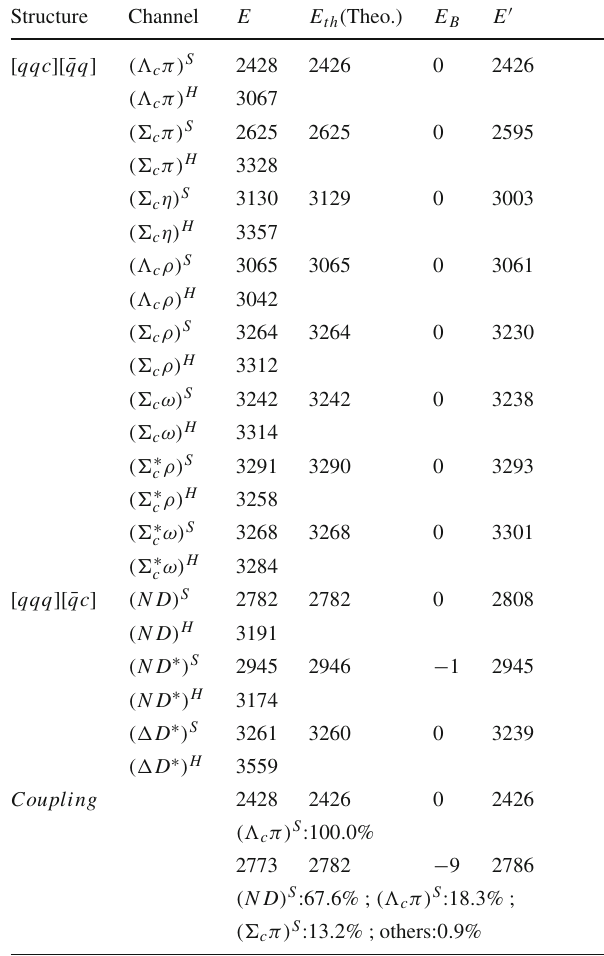
Table 14 The RMS distances of the qqq ¯ qc pentaquark system with quantum numbers I ( J P ) = 1 ( 1 Structure